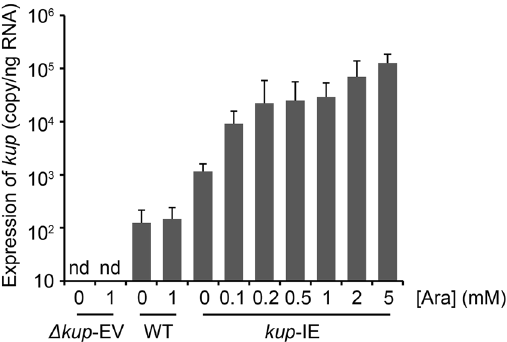
Figure 2. Arabinose-induced expression of kup in the E. coli strains. Each strain was cultivated in the K + -free minimal medium supplemented with 10 µ M of KCl and different concentrations of arabinose. Total RNA was extracted from the early stationary phase cells and was subjected to the qRT-PCR analysis targeting the kup gene. Data are presented as means of triplicate experiments, and error bars represent standard deviations.